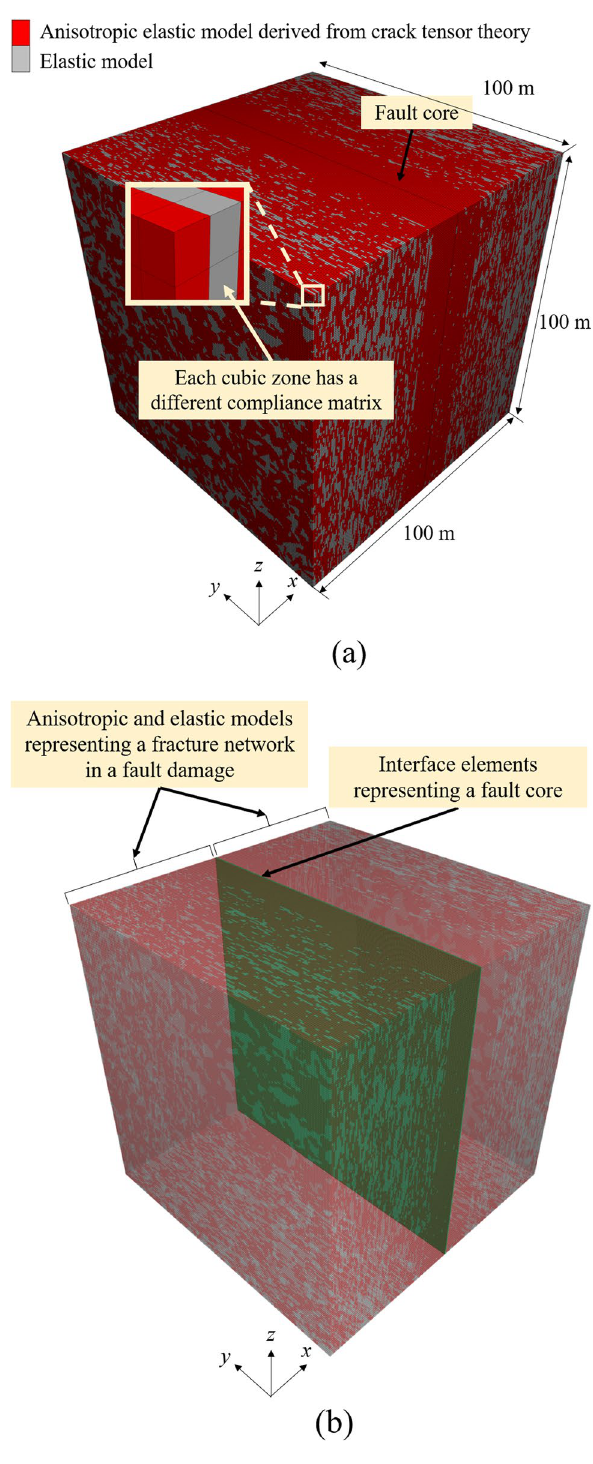
Fig. 4 Numerical model showing zones with anisotropic or isotropic compliance